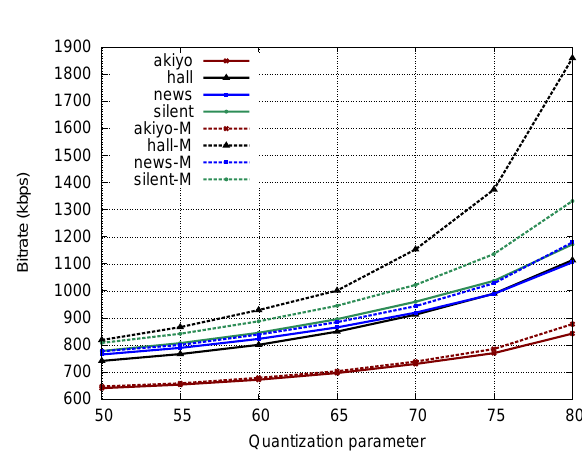
Figure 12. Bitrate comparison: JPEG with DPCM and JPEG in simulated model at QP [50-80].